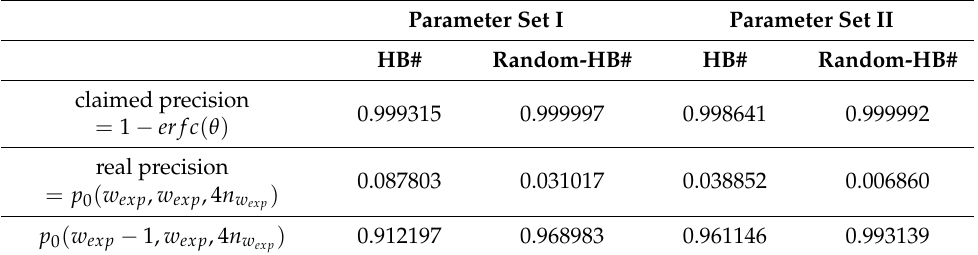
Table 2. Comparison of the claimed and real precision of the OOV weight estimate showing that the real precision is remarkably smaller than the claimed